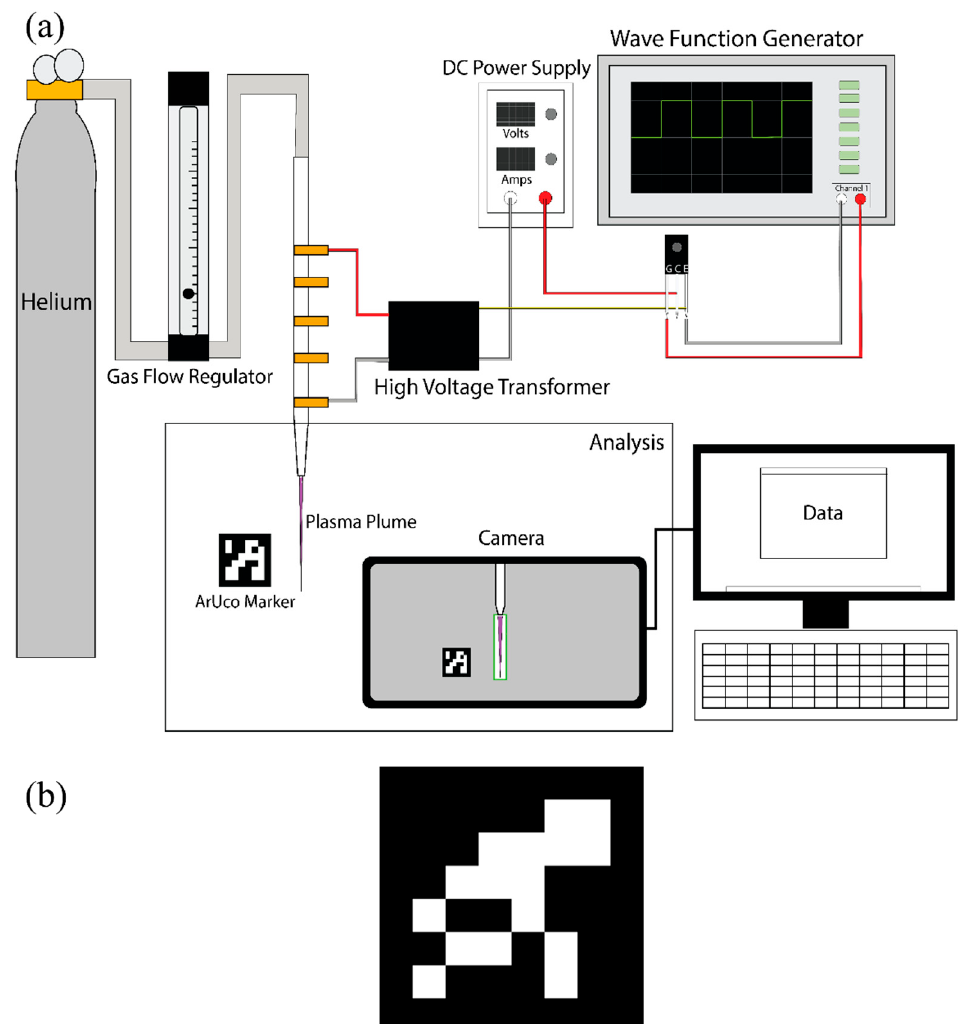
Figure 2. Real–time computer recognition system. ( a ) Full schematic of plasma plume and image analysis setup shows how plasma was generated, how measurements were taken, and component connections. The specific camera used was an iPhone 11 attached via cable to a laptop computer running the software where video stream from the camera was accessed. The electrode gap can be easily varied by choosing any two electrodes of the five copper ring settings. ( b ) ArUco marker used in camera calibration. ArUco markers are frequently used in computer vision applications because there is significant open-source material supporting them. This project takes advantage of the li- brary function cv2.aruco.detectMarkers() to return pixel (px) coordinates of ArUco markers from a specific set.